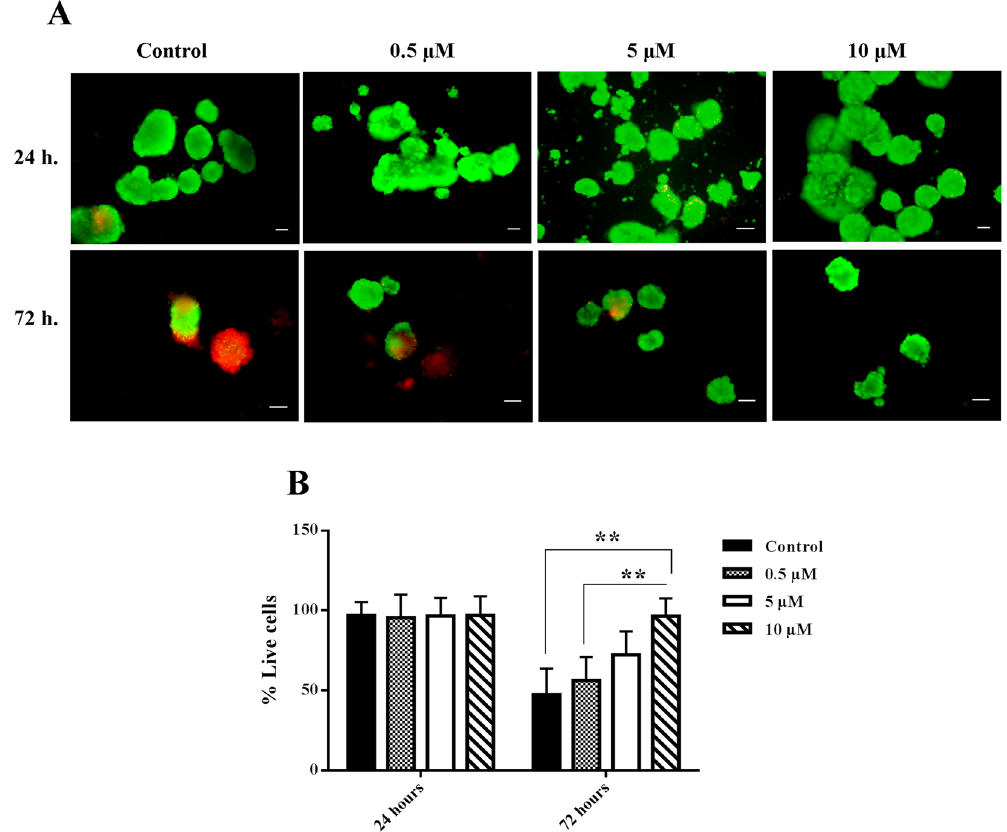
Figure 1. Islet viability evaluation was done by Fluorescein diacetate and propidium iodide staining in different concentrations of nobiletin. ( A ) Green cells were alive and red cells were dead. Scale bars = 100 and 200 μ m. ( B ) The percentage of live cells was also calculated and shown as charts. The experiment was done in triplicate from four donors and data were analyzed by Kruskal-Wallis and Post-hoc tests. The results were represented as mean ± SD. ** p <